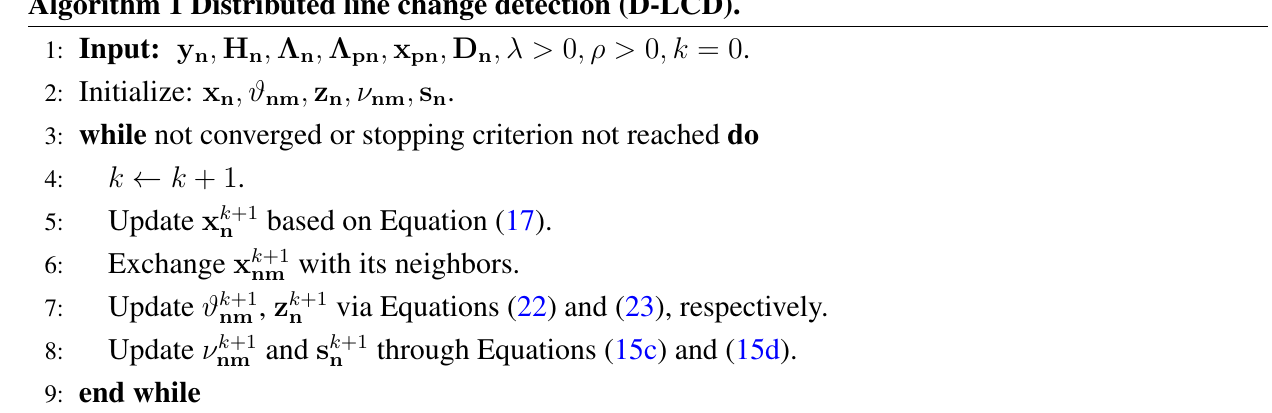
Algorithm 1 Distributed line change detection